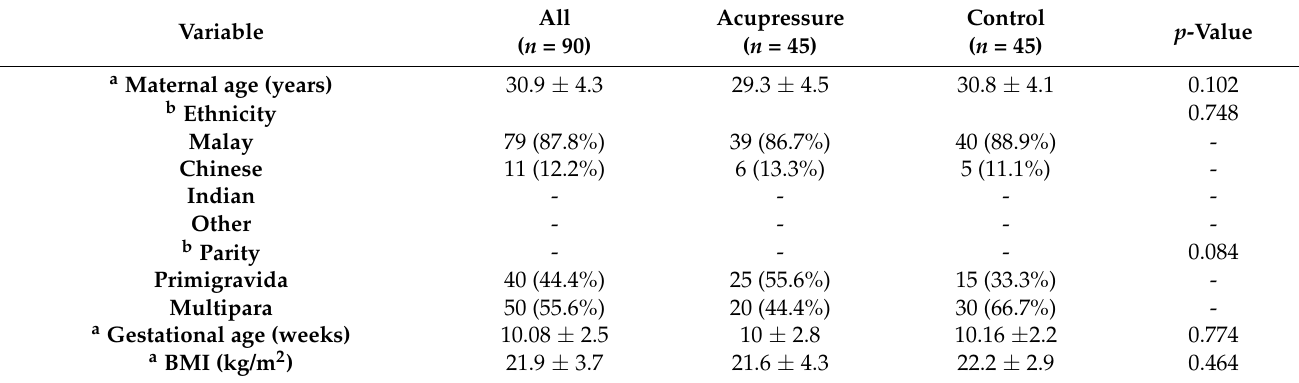
Table 1. Baseline characteristics of